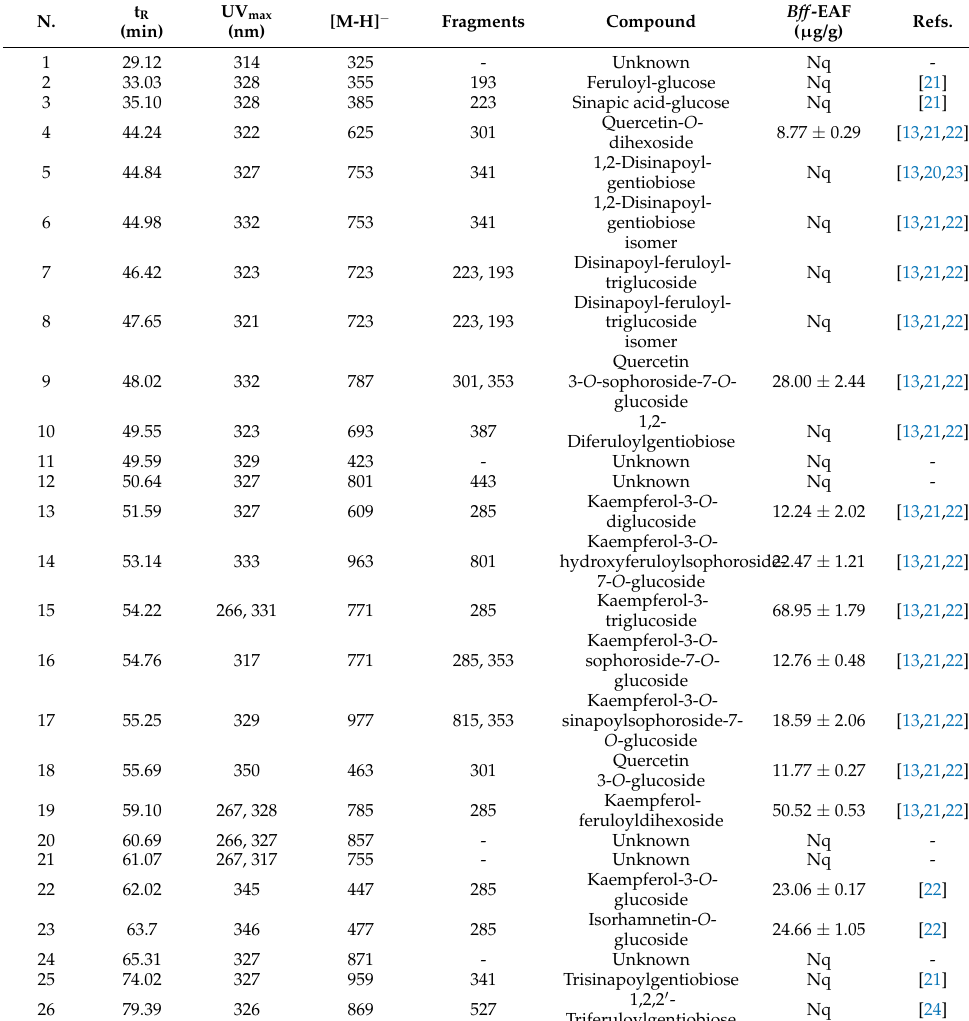
Table 1. HPLC-PDA/ESI-MS (negative ionization mode) polyphenolic fingerprint of Bff -EAF. Results are expressed as µ g/g fraction ± SD ( n =